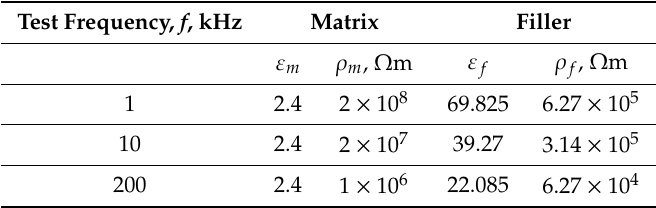
Table 2. Specific parameters used for the